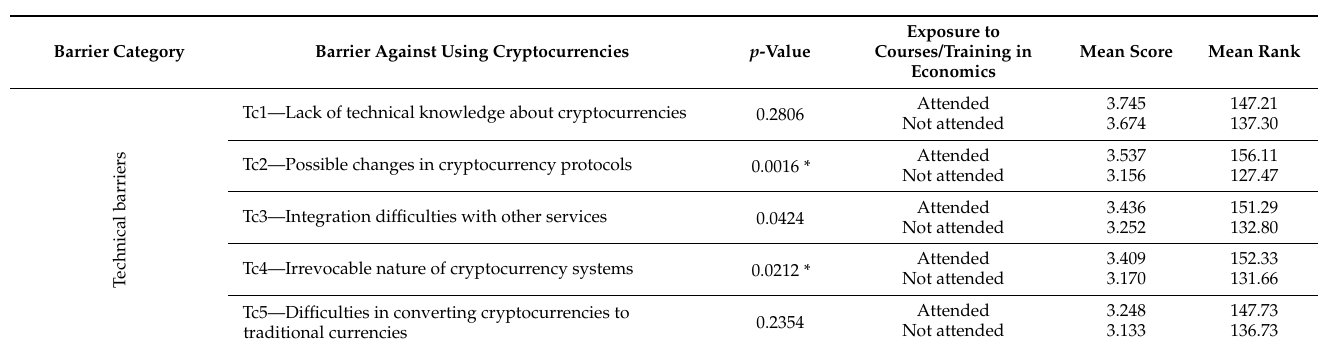
Table 4. Results of Mann–Whitney U test based on respondents’ knowledge about the basic principles of